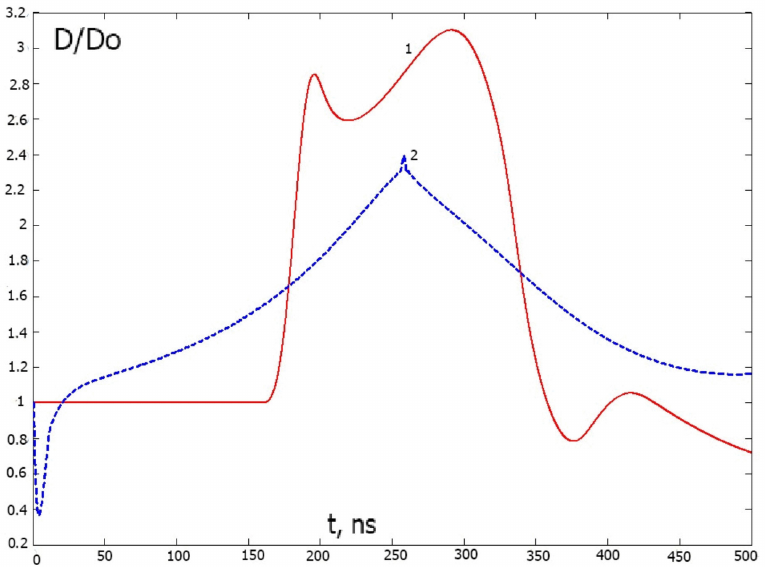
Figure 2. Change in density on the axis (1) and at the plasma boundary (2). The plasma density on the axis exceeds the critical value for 15 ns.